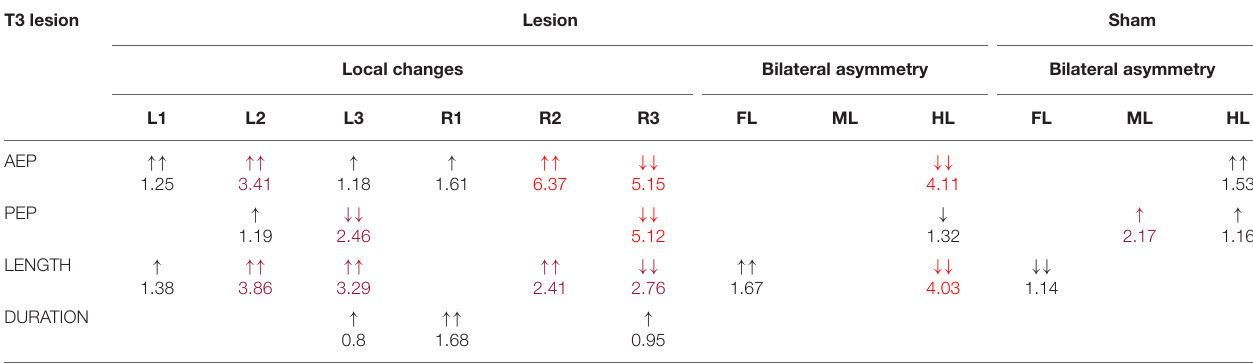
TABLE 2 | Summary of the changes in step parameters induced by a lesion of the meso-to-metathorax connective. T3 lesion Lesion Sham